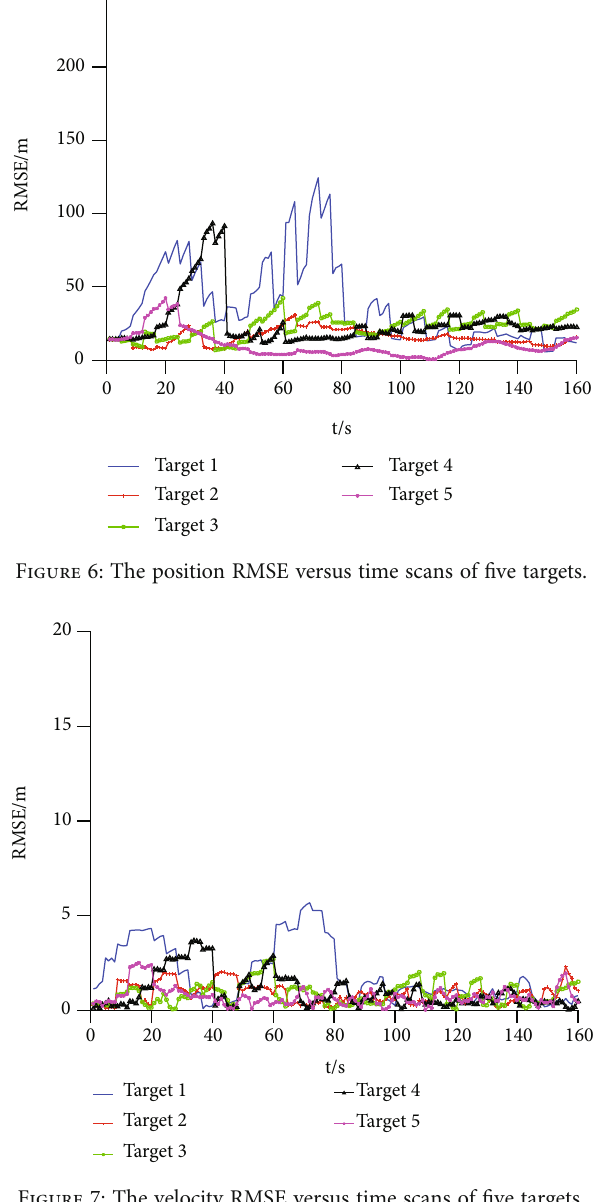
Table 3: The average position RMSE of fi ve targets.